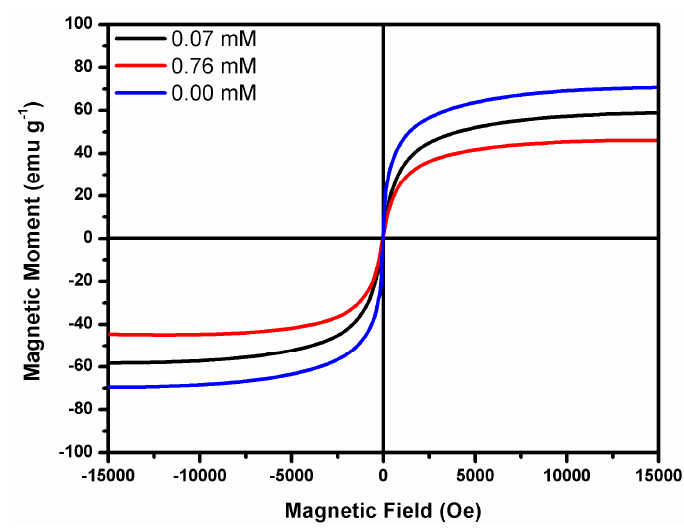
Figure 8. Magnetization curves of MIONs prepared with 0.072, 0.768 and 0.00 mM concentration of PTMP-PMAA.